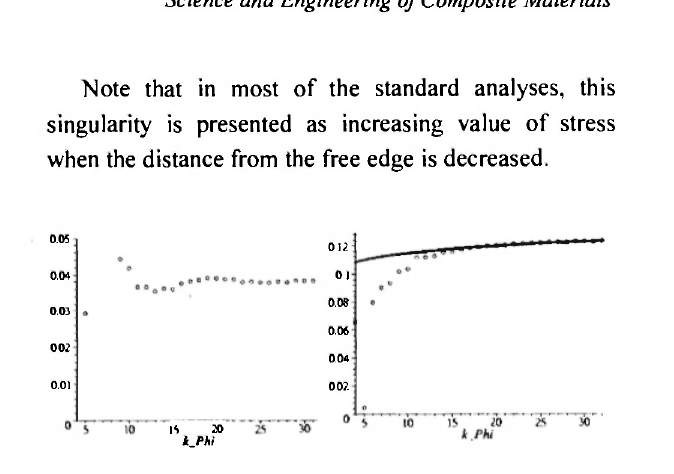
Fig. 9: The stress at two edge locations vs. £φ (/=10, 2=5).